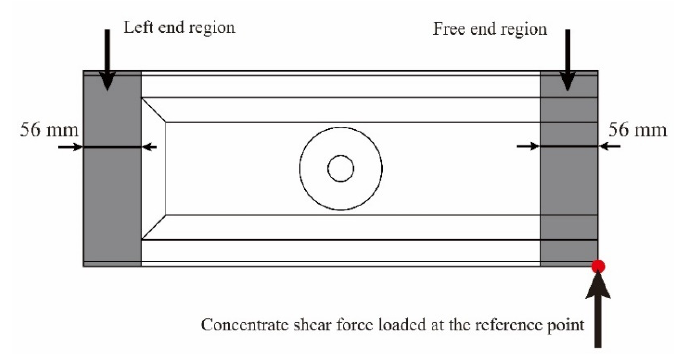
Figure 15. The application of the shear loading and the setting of the boundary conditions for the macro-scale FE models.